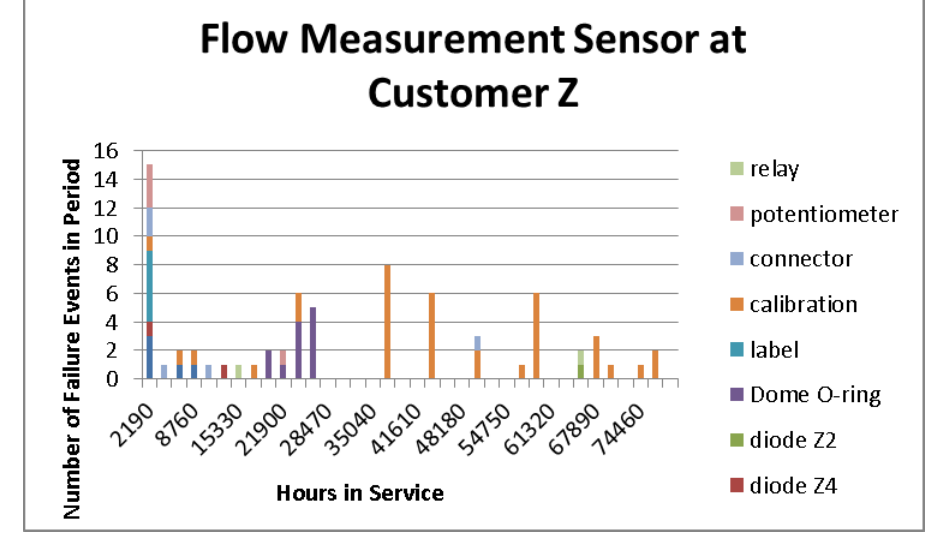
Figure 2. Measurement Instrument Failure Events by Failure Mode.